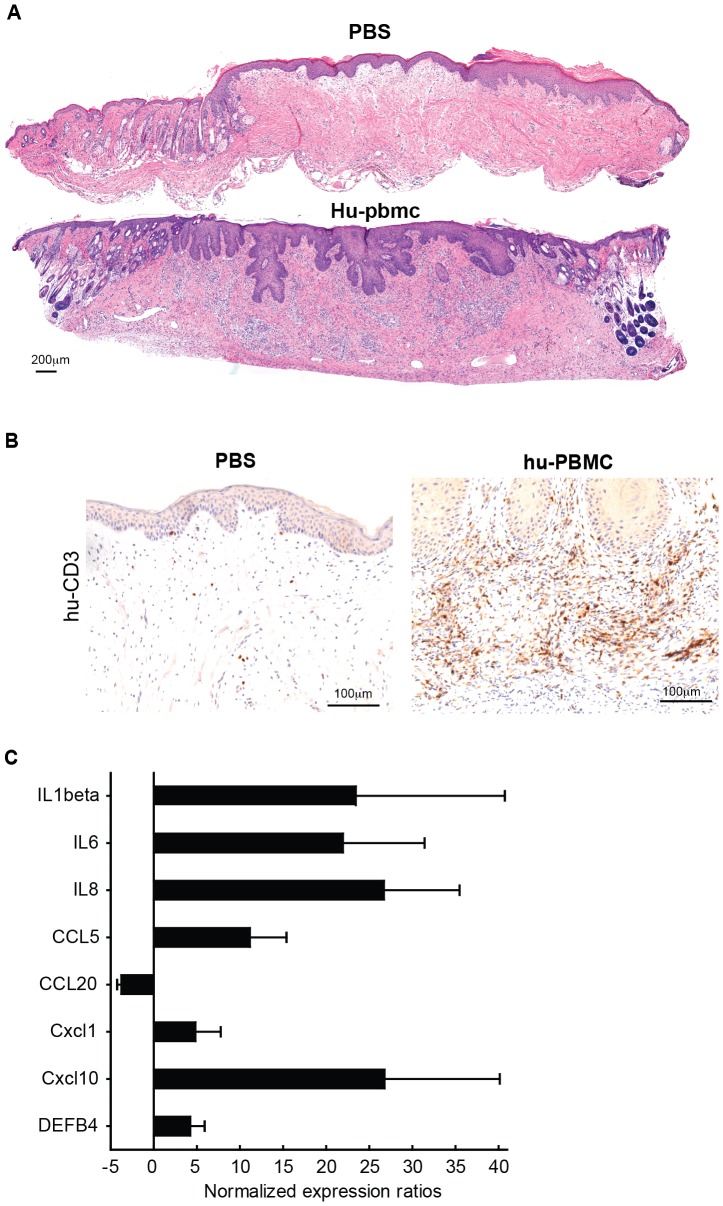
Induction of human chemokines and cytokines and influx of human T cells in the dermis and in the epidermis of huPBL-SCID-hu Skin allograft model.
A. Images show representative panoramic overviews (H&E staining) of human skin grafts from SCID beige mice 21 days after infusion (i.p.) of PBS (top) or huPBMC (below). Note that human epidermis is thicker than the mouse epidermis (present in the left edge of the specimen in the top image and in both edges in the bottom image) and in contrast with human skin, mouse skin has closely spaced hair folicules troughout the epidermis. Images were composed using PTGui software (New House Internet Services B.V.; http://www.ptgui.com/). B. Immunohistochemistry of human CD3+ (brown) T cell infiltration in the human dermis and epidermis, 21 days after infusion of huPBMC. Representative example of n = 12 are shown. 20× magnification. C. Gene expression analysis using quantitative real-timePCR of human cytokine and chemokine transcripts in the human skin 21 days after infusion of huPBMC. Figure shows fold increase in cytokine and chemokine mRNA expression levels after huPBMC infusion as compared to PBS infusion (n = 5 and 3; huPBMC and PBS resp.).